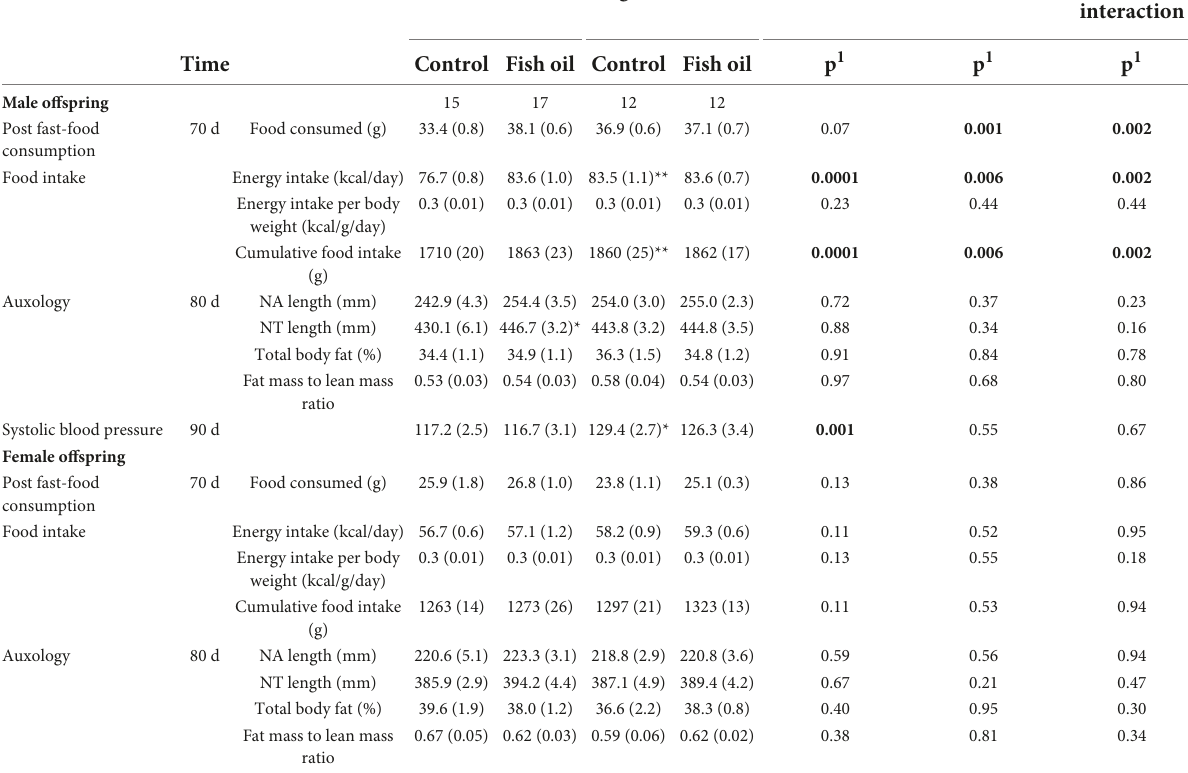
TABLE 8 Adult metabolic and body composition